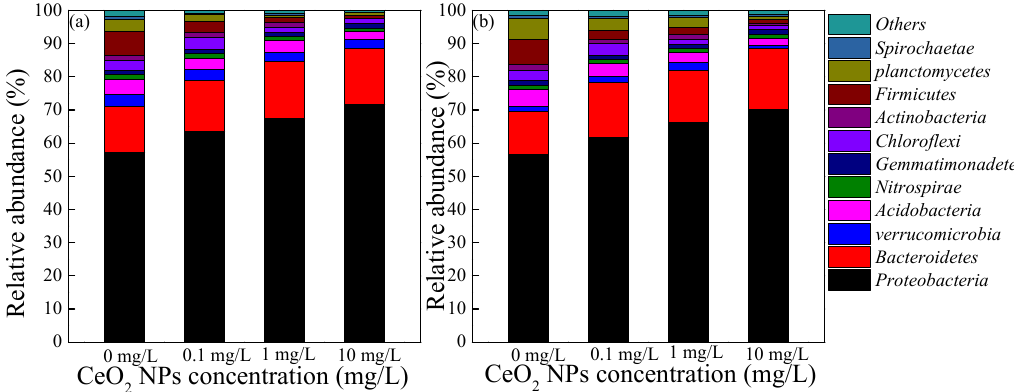
Figure 6. The shift of the microbial community at the phyla level in damaged sludge before ( a ) and after ( b ) the two-week recovery period after relief from different CeO 2 NP concentrations.